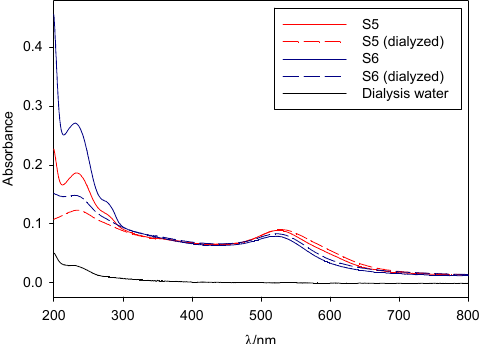
Figure 4. Before and after dialysis spectra for samples S5 and S6.